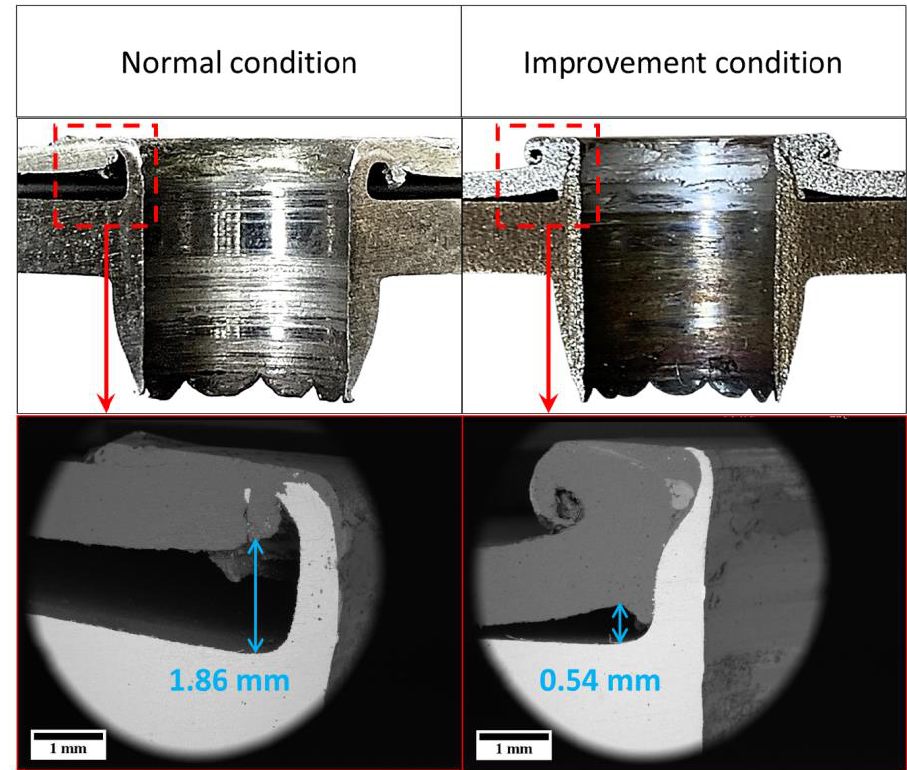
Figure 13. Cross-section and close-up views of back-extruded materials zones for friction-drilled joints under normal and improvement conditions.